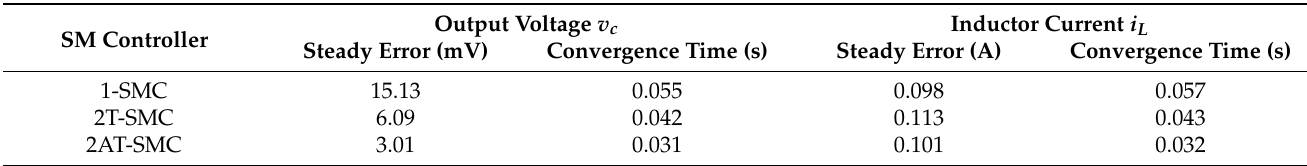
Table 2. Performance comparisons of the buck converter system in rated working case.